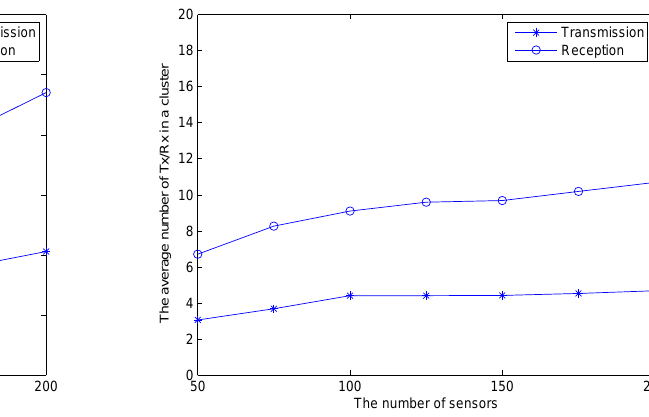
Figure 22. Communications of key distribution process; total number of transmission and reception in the network (left), the average number of transmission and reception in a cluster